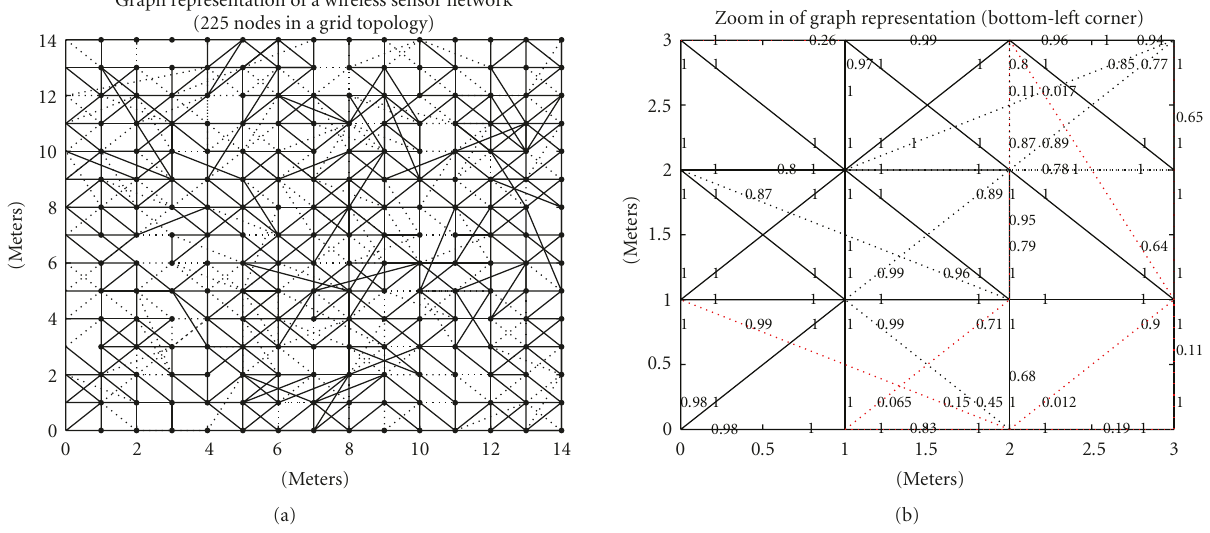
Figure 3: (a) Asymmetric graph; 225 nodes. (b) Zoom in of asymmetric graph: bottom-left corner, 16 nodes. The PRR of a given directed link is written close to the transmitter. For example, the link from (0,0) to (1,0) has a PRR of 0.98, and the link from (1,0) to (0,0) has a PRR of